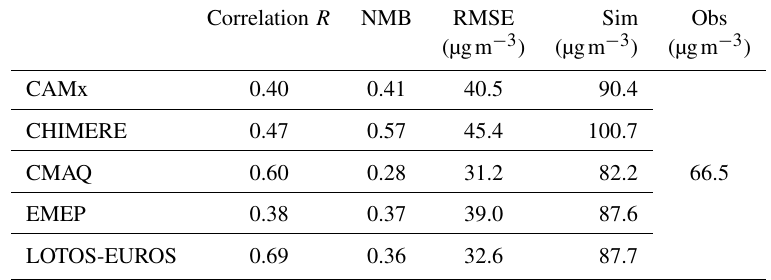
Table 5. Correlation, normalized mean bias (NMB), root mean square error (RMSE), and observational (obs) and simulated (sim) of O 3 as the mean values for 2015: the first data were averaged station-wise and then averaged for all 48 stations.